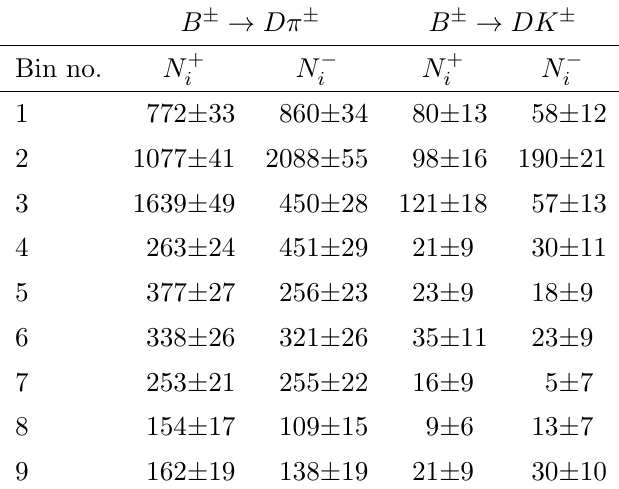
Table 5 . Signal yields in each D phase space bin for B (cid:6) ! D(cid:25) (cid:6) and B (cid:6) ! DK (cid:6) data samples obtained from a simultaneous (cid:12)t to the nine bins.